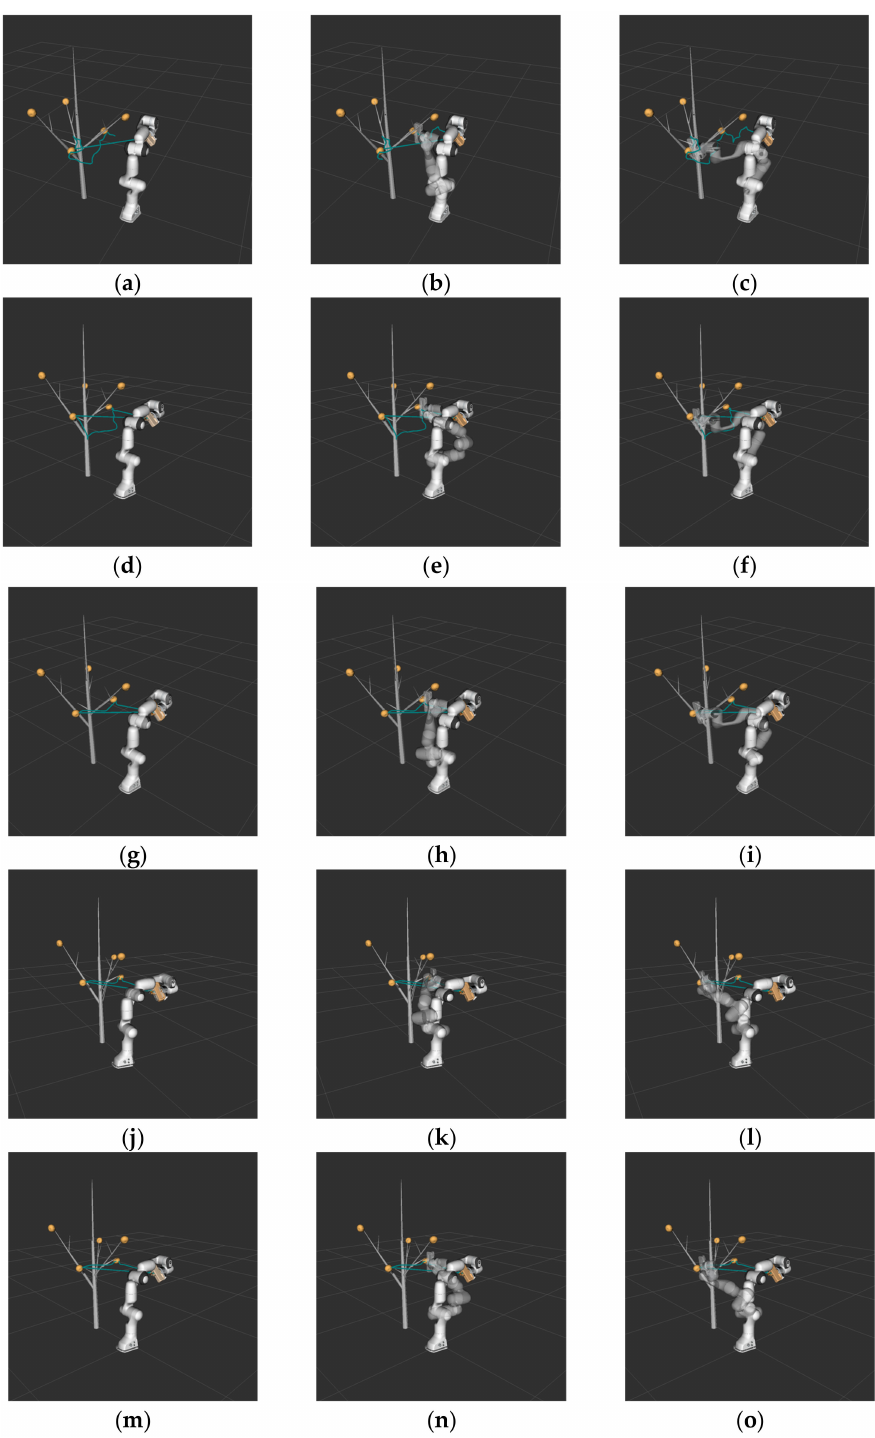
Figure 14. The use of MoveIt! with: the RRT algorithm ( a – c ); the biased-RRT algorithm with a target offset probability of 50% ( d – f ); the TO-RRT algorithm ( g – i ); the RRT-BCR algorithm ( j – l ); and the NC-RRT algorithm ( m – o